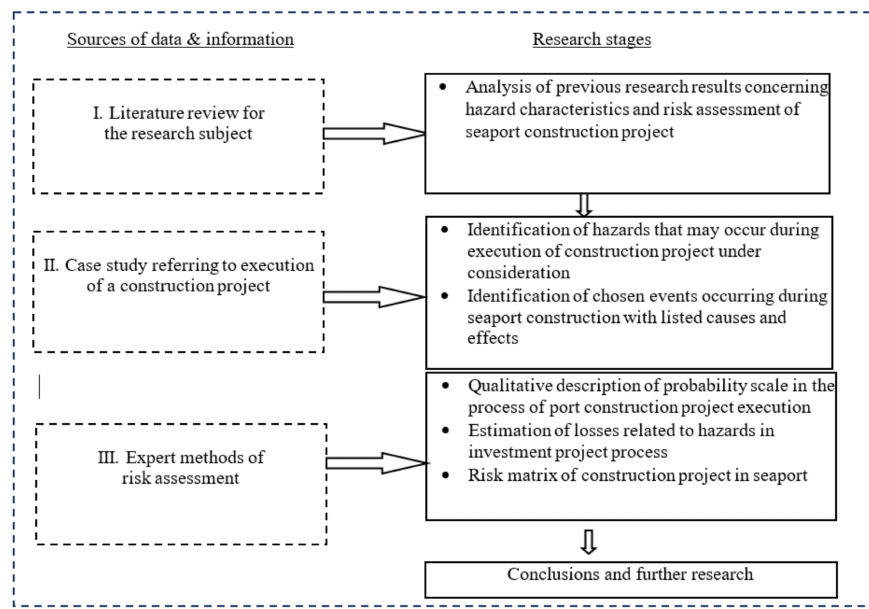
Figure 1. Research methodology